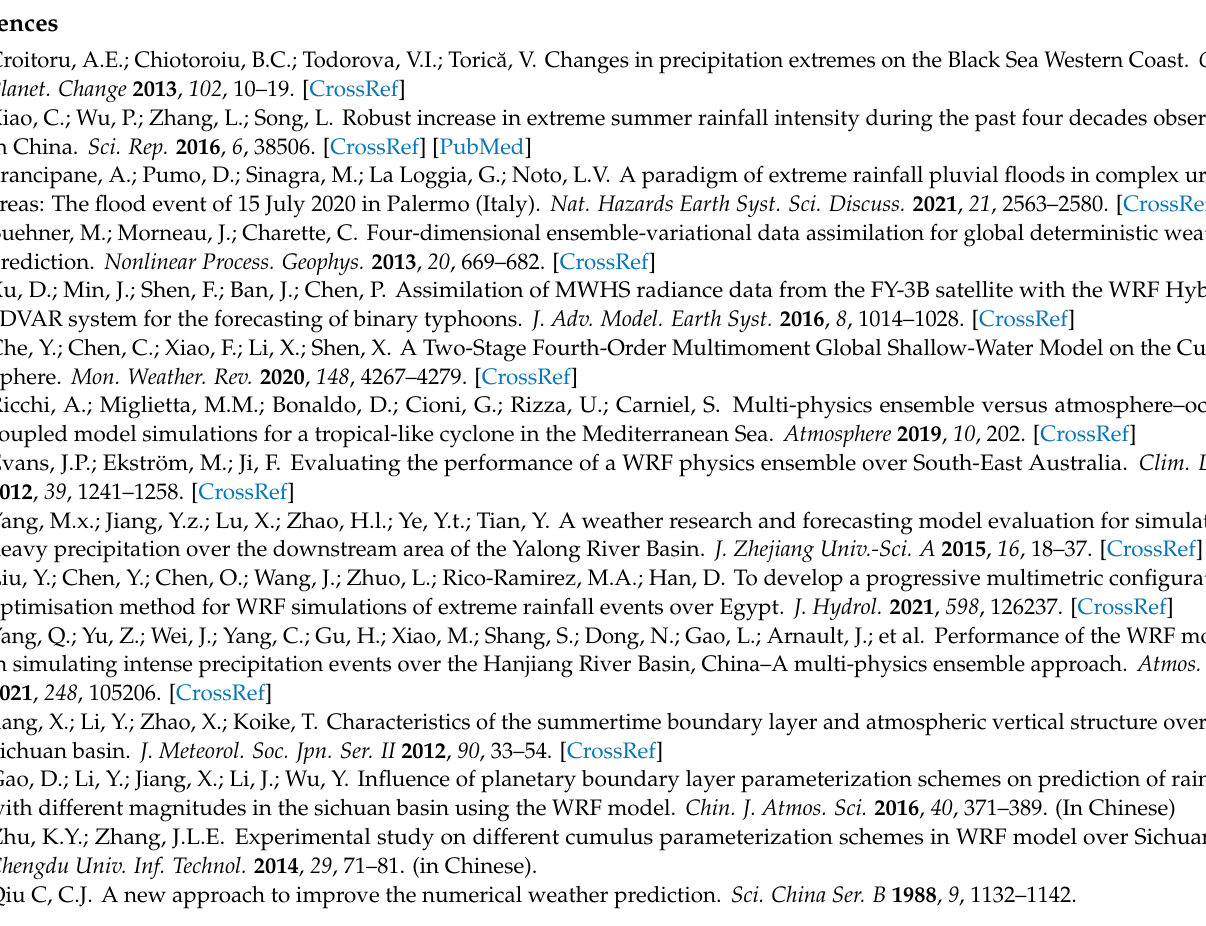
Figure A6. The temporal evolution of a small area (103° E–107° E, 29° N–33° N) averaged 2-m temperature and dew point temperature ( ◦